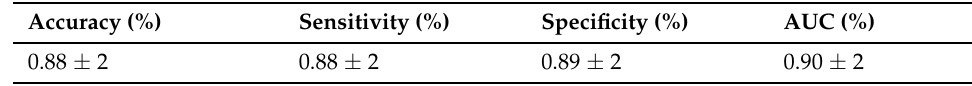
Table 2. Classification performance on test set.